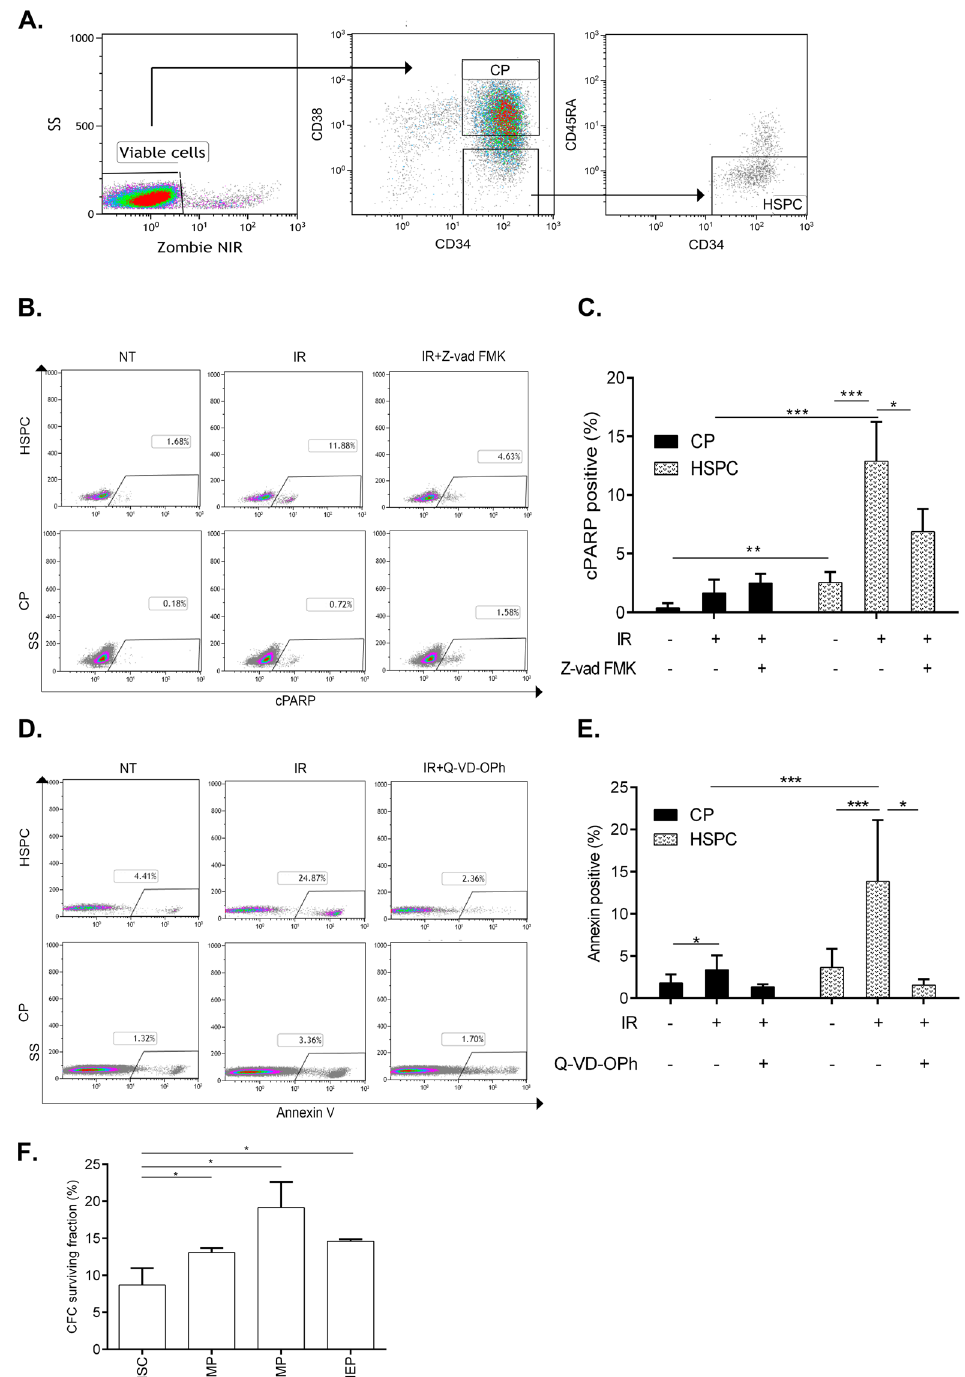
Figure 1. Analysis of IR-induced apoptosis in different fractions of primitive human hematopoietic cells. (A) Flow cytometry gating strategy for HSPCs and CPs. (B,D) Example of FACS data identifying cPARP + (B) and AnnexinV + (D) fractions in HSPCs and CPs gated as described in (A) 6 h after 3 Gy IR-treatment. (C,E) CD34 + cells were pre-treated with Z-vad-FMK (100 μ M), Q-VD-OPh (20 μ M) or DMSO for 1 h, irradiated with 3 Gy and analyzed for cPARP + or Annexin V + cells in HSPCs and CPs 6 h later, n ≥ 3. ( F ) Survival of clonogenic cells from sorted HSPC (CD34 + CD38 − /low CD90 + 45RA − ), CMP (CD34 + CD38 + CD45RA − CD135 + ), GMP (CD 34 + CD38 + CD45RA + CD135 + ) and MEP (CD34 + CD38 + CD45RA − CD135 − ) fractions following IR with 3 Gy. CFC surviving fraction was calculated by dividing number of colonies counted in the irradiated plates by the number of colonies from the same fraction scored in the non-irradiated plates, n = 3. Represented are mean values ± SD; * p < 0.05, ** p < 0.01, *** p <